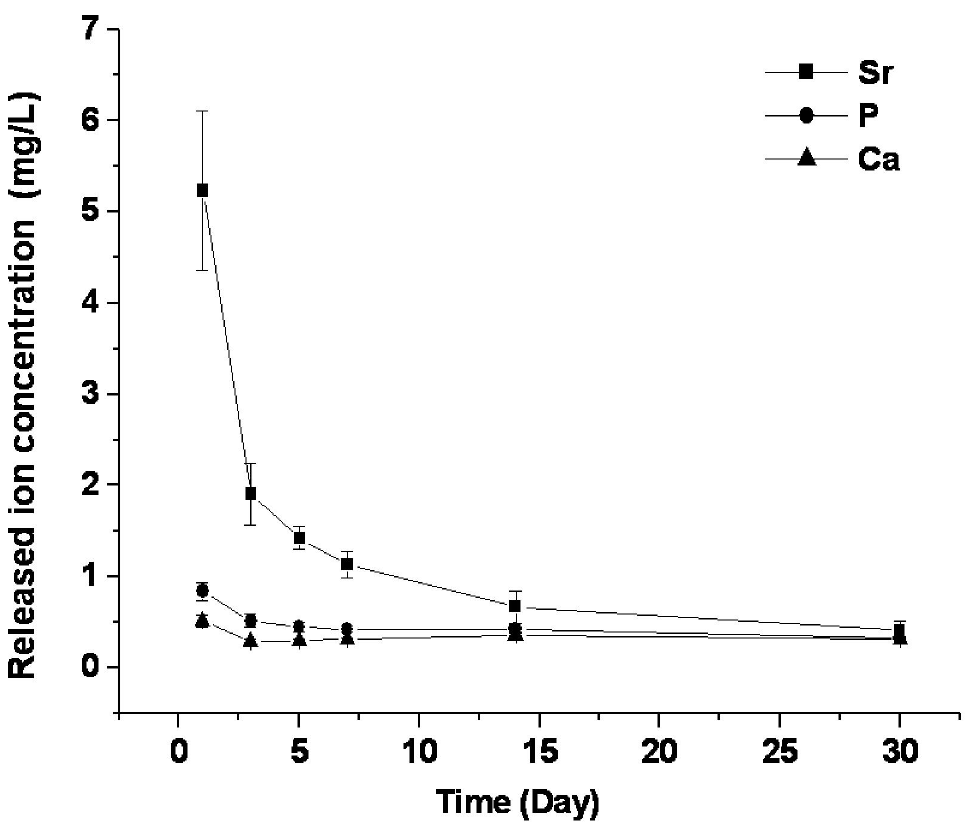
Figure 4. Release curve of strontium ions from Sr-doped ABS into deionized water. doi: